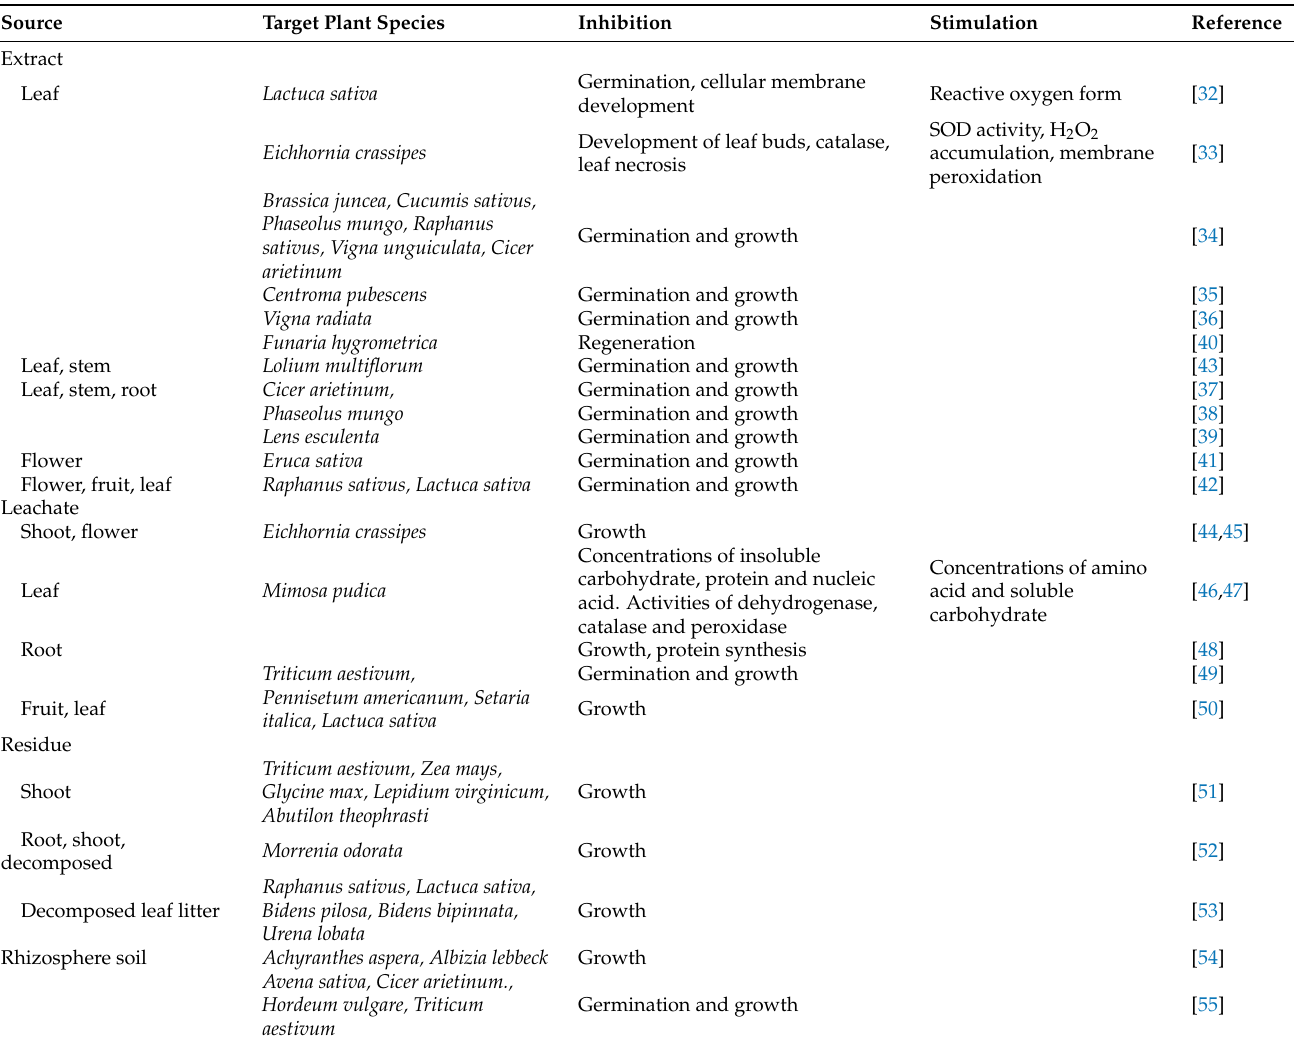
Table 1. Allelopathic activities of the extracts, leachates, residues, and rhizosphere soil of Lantana camara